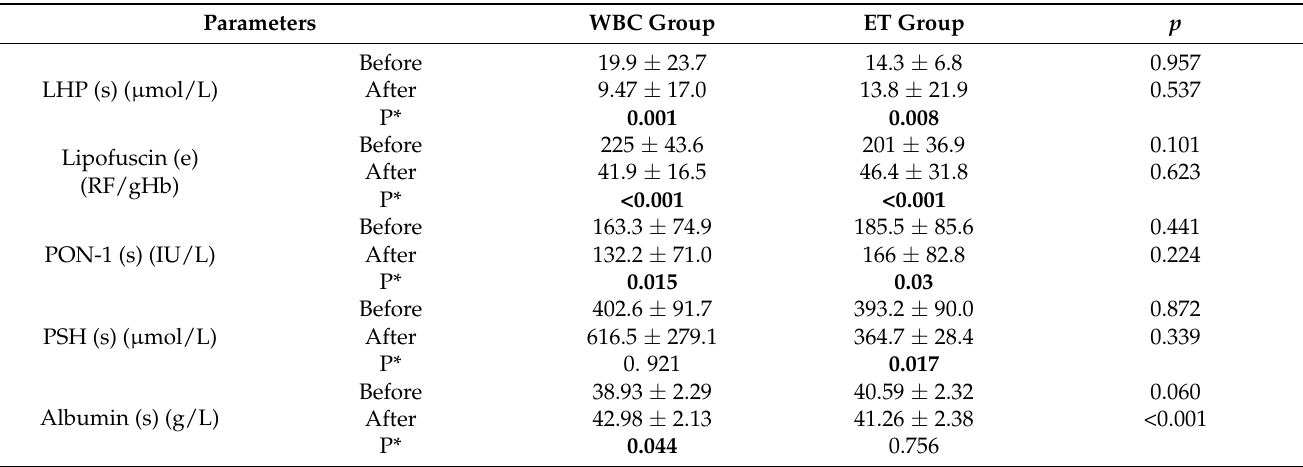
Table 3. Oxidative stress parameters (mean value ± standard deviation SD) in AS patients before and after the treatment in studied groups.